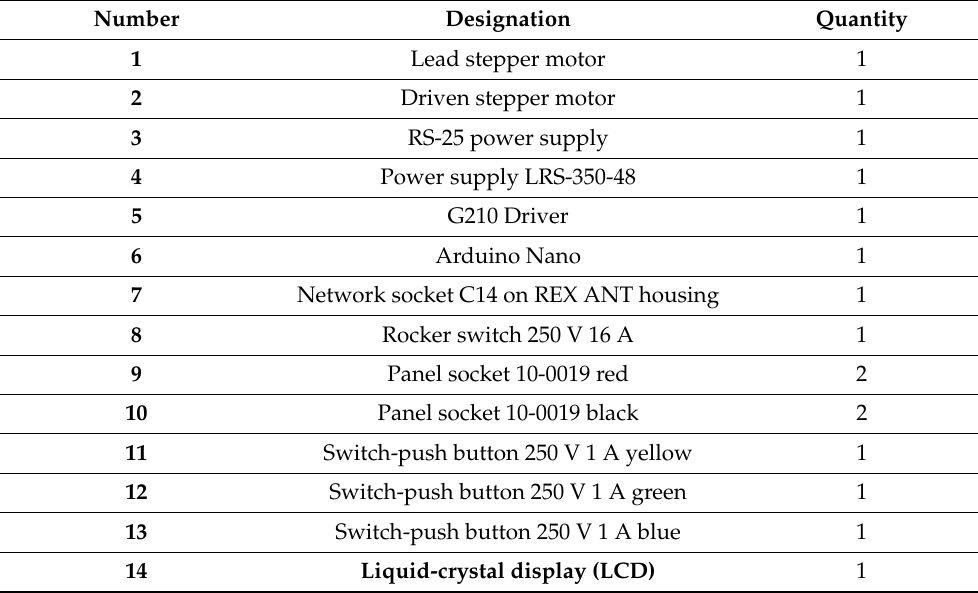
Table 1. Components of the designed